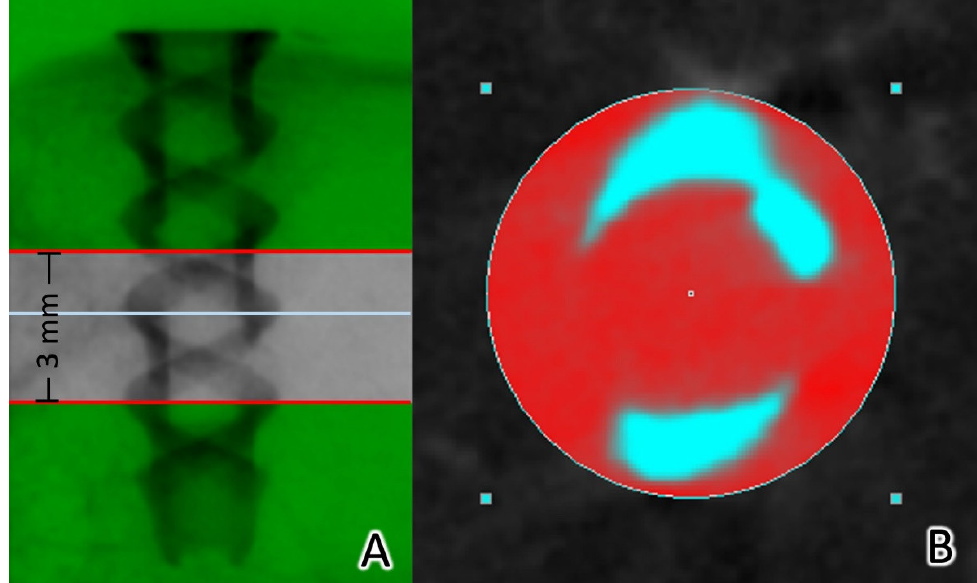
Figure 5. The reconstructed cross-sections were re-orientated, and the region of interest (ROI) was further selected. The 3.5 mm implant column was isolated. ( A ) The analysis was performed with 3 mm images (100 slices, 3–6 mm from the end of the implant). Automatic Ostu thresholding and bone ingrowth analysis were performed using CTAn software. ( B ) The ROI was defined as a 200–1000 μm region around the implant.